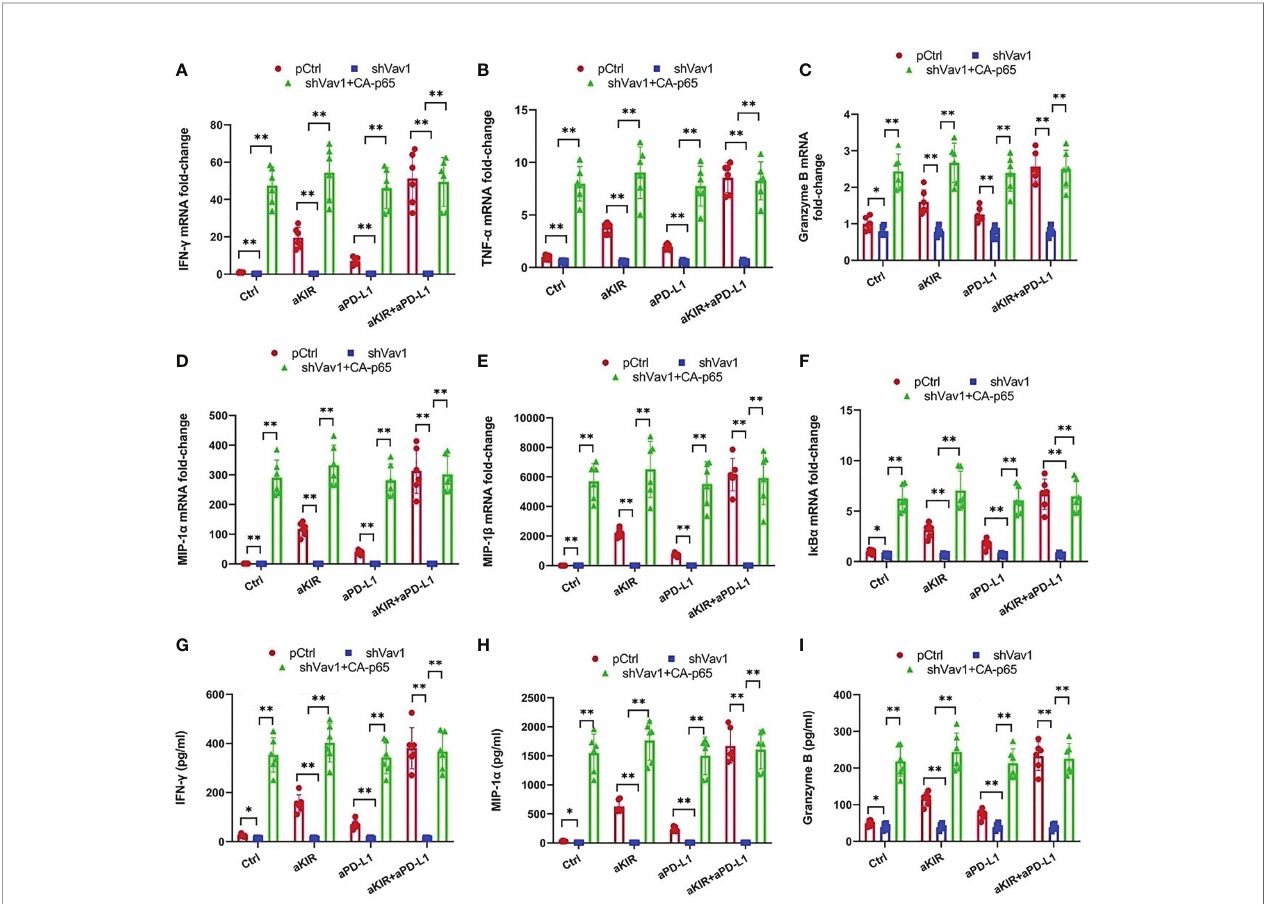
FIGURE 6 | Cytokine and Granzyme B Upregulation by Lirilumab and Avelumab Co-Engagement is Vav1-Dependent. (A-F) Transfected IL-2-primed NK cells were mixed with autologous target cells and stimulated with aKIR and/or aPD-L1 for 3 h. Relative mRNA levels of (A) IFN- g , (B) TNF- a , (C) granzyme B, (D) MIP-1 a , (E) MIP-1 b , and (F) I k B a were determined by real-time PCR and normalized to b -actin mRNA expression. (G-I) Transfected IL-2-primed NK cells were mixed with autologous target cells and stimulated as in (A-F) for (G, H) 8 h or (I) 2 h. (G) IFN- g , (H) MIP-1 a , and (I) Granzyme B were measured by ELISA. * P < 0.05, ** P < 0.01 [two-way ANOVA (mAb factor × transfection factor)]. n=3 biological replicates×3 technical